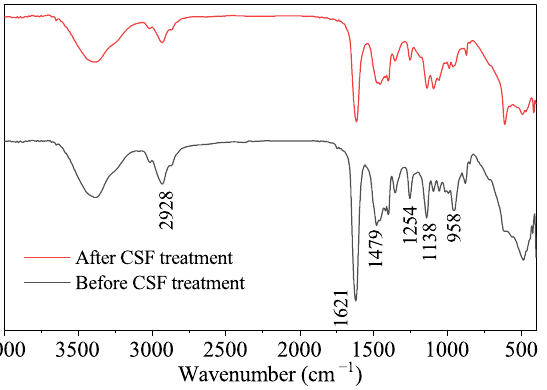
Figure 7. FTIR spectrum of the SAP before CSF treatment and after CSF treatment for 300 min at 90 ◦ C.